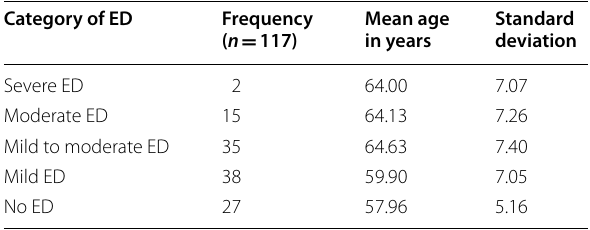
Table 1 Mean age versus severity of ED in 117 patients with